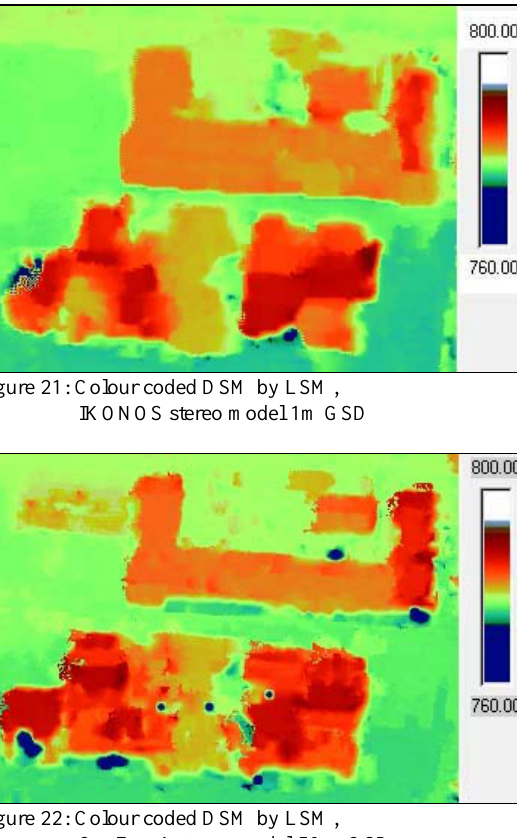
Figure 22: Colour coded DSM by LSM, GeoEye-1 stereo model 50cmGSD